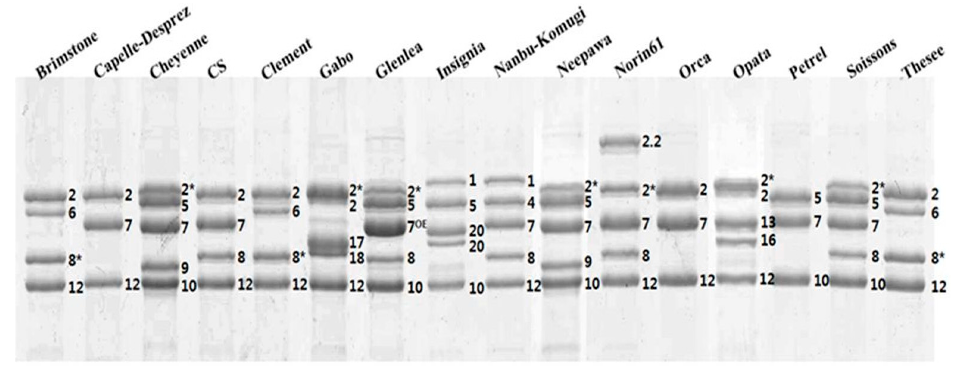
Figure 2. HMW-GS profiles of standard wheat cultivars determined by SDS-PAGE.